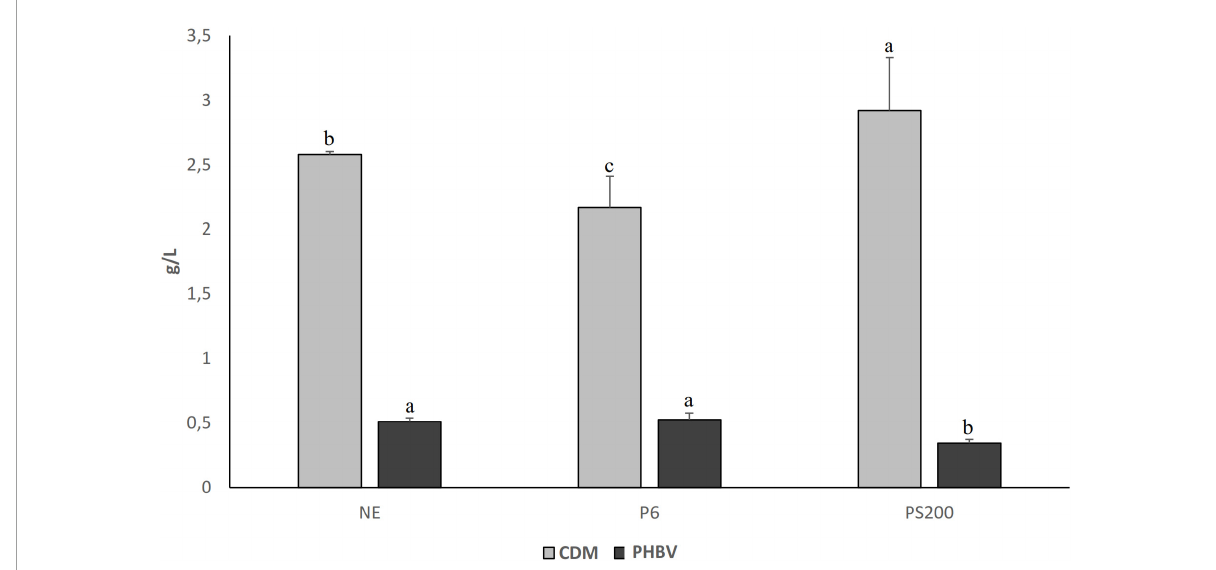
FIGURE3 Cell dry matter (CDM) and PHBV production by Hfx. mediterranei DSM1411 in different wasted bread derived substrates produced using pepsin for 6 h (P6), Veron PS at the concentration of 200 g/100 kg (PS200) and without enzymes (NE) and diluted in the ratio 40:60 v/v/ with microfiltered seawater. The data are the means of three independent experiments ± standard deviations ( n = 3). a − c Values of the same dataset with different superscript letters differ significantly ( p < 0.05).